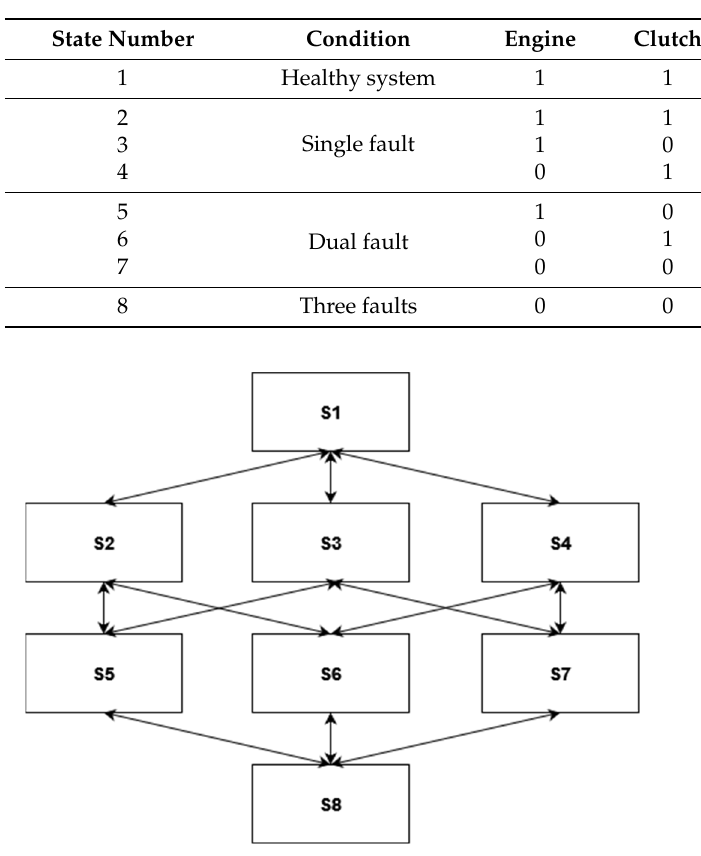
Figure 12. Markov chain of the conventional system.